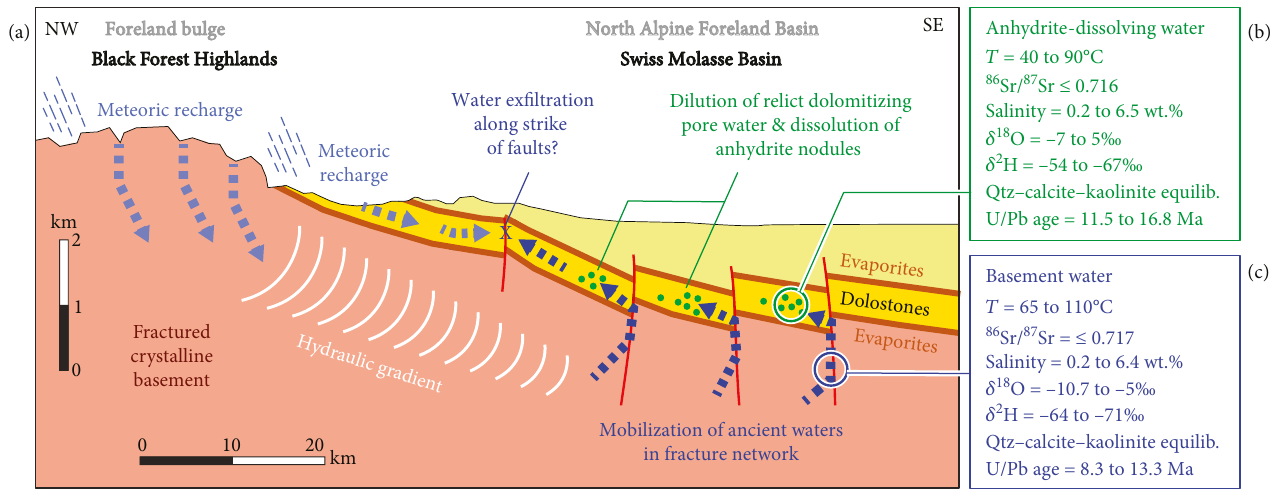
Figure 16: (a) Schematic geological cross section illustrating upwelling basement water leading to anhydrite dissolution and generation of secondary porosity in the Muschelkalk dolostones (note vertical exaggeration; see text for details). (b) Properties of anhydrite-dissolving fl uid deduced from evidence within dolostones. (c) Matching properties of pore water deduced from evidence in basement